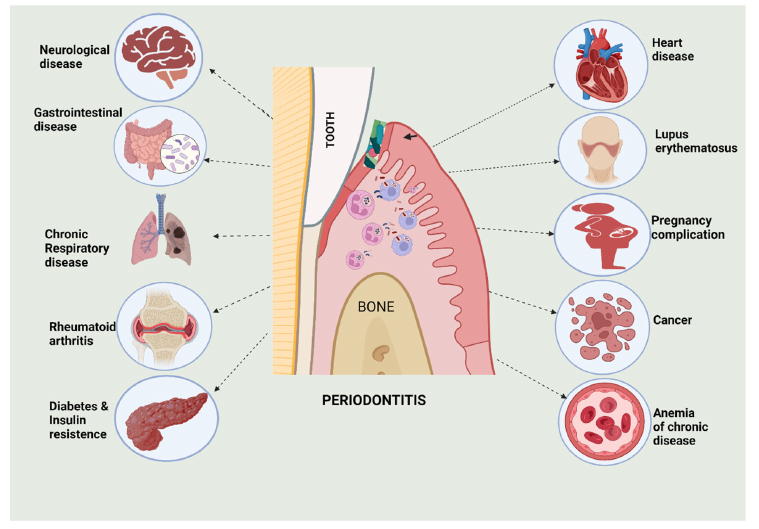
Figure 1. Representation of diverse systemic diseases and their relationship with periodontitis. This figure was created with Biorender.com (accessed on 9 September 2022).